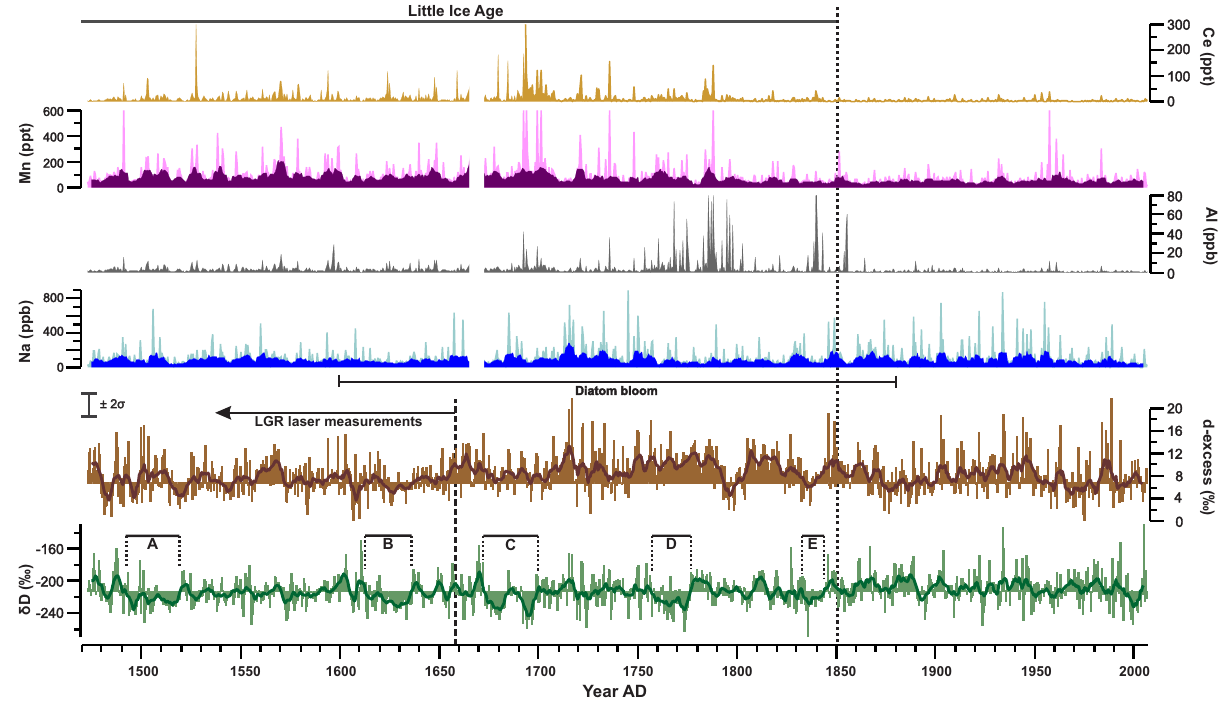
Fig. 6. Stable isotope and chemistry records from the MES ice core re-sampled to 2 samples yr − 1 . 5yr smoothed time series are plotted in bold colours for all time series except Al and Ce. δ D and d-excess are plotted around 1950–2006AD mean values. Letters A–E indicate anomalously cold time periods referred to in the text. LGR laser measurements of δ D and d-excess have been adjusted (Supplement). The d-excess analytical error applicable to the entire dataset is indicated. Al plot is clipped at 80ppb and Mn plot is clipped at 600ppt. Timing of a diatom bloom reported by Leventer and Dunbar (1988) in four sediment core records from the north-west of Ross Island in McMurdo Sound is indicated. The gap in ICP-MS data is due to the removal of anomalously high chemistry concentrations relating to a tephra layer in the ice